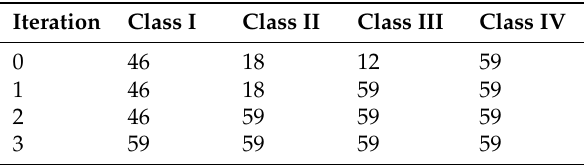
Table 7. Nepal—Random Over-sampling of data [62].